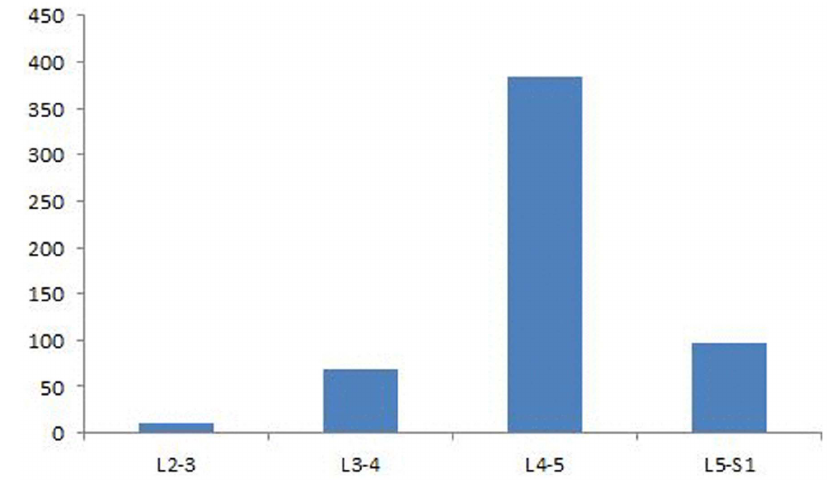
Figure 2. Spinal level of cysts diagnosed in the patients included in the meta-analysis.